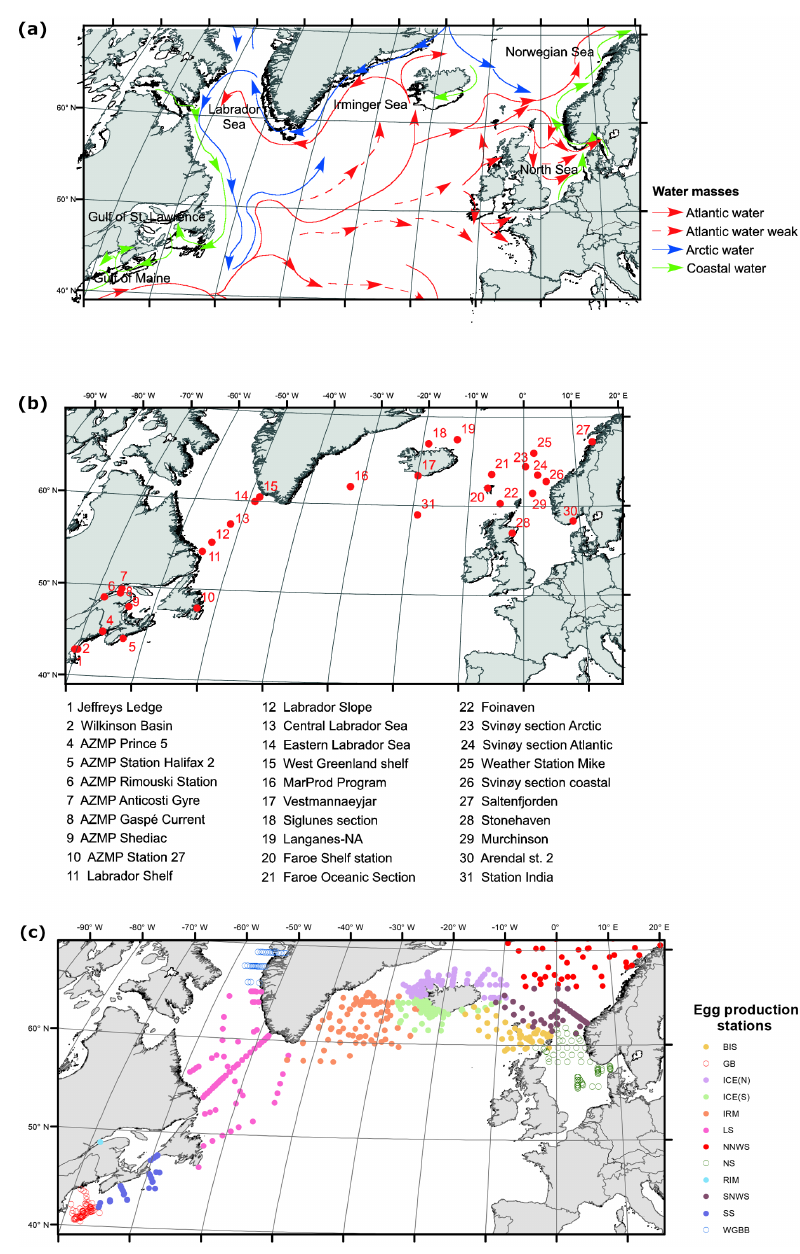
Figure 1. Panel (a) : the northern North Atlantic Ocean, major warm and cold water currents, and important seas. Panel (b) : locations of demographic stations and transects listed in Table 1. Panel (c) : locations of observations of C. finmarchicus egg production rates (and usually adult body size, chlorophyll a concentrations and